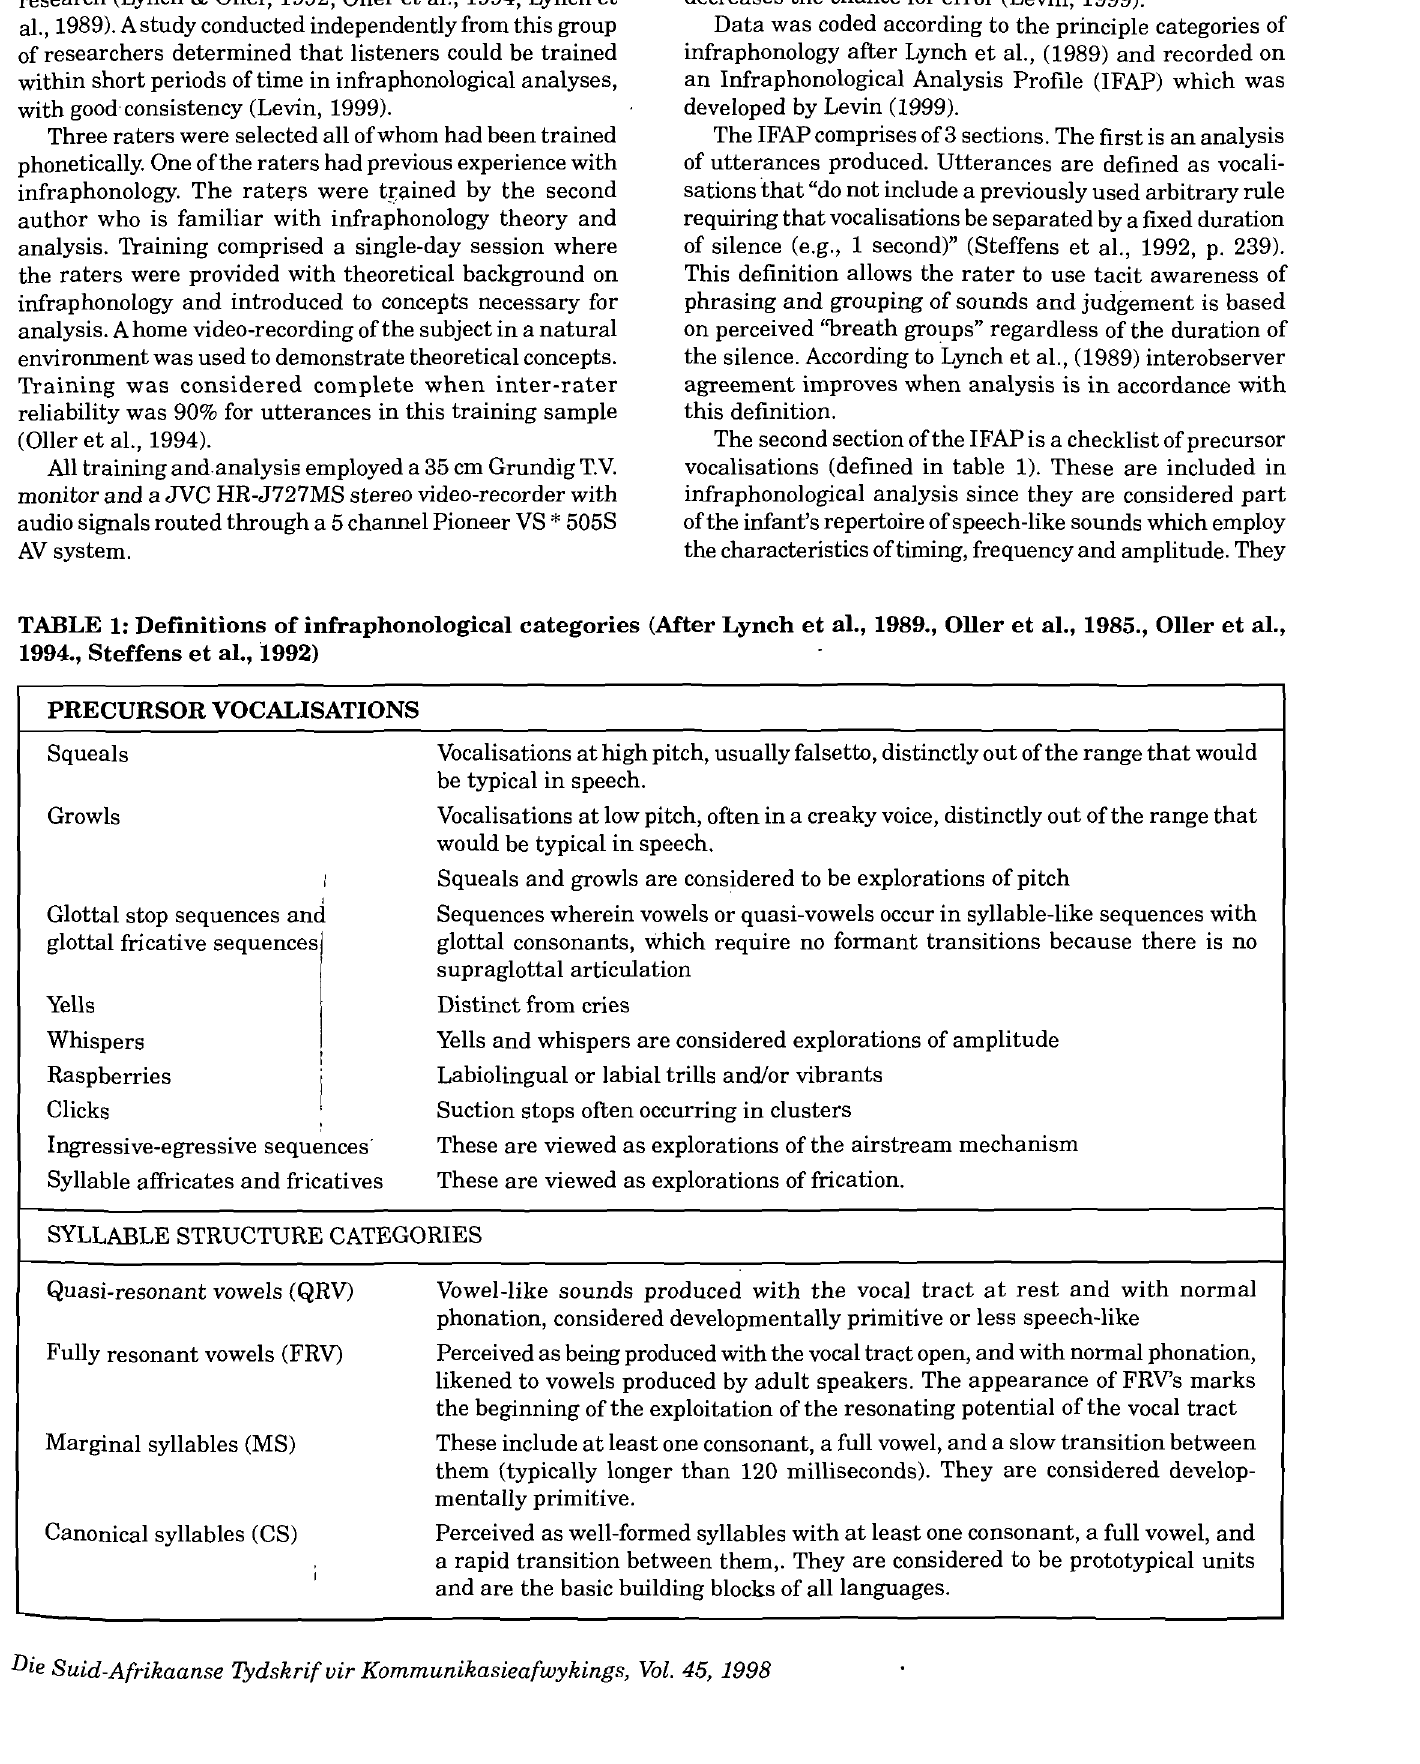
TABLE 1: Definitions of infraphonological categories (Mter Lynch et aI., 1989., Oller et aI., 1985., Oller et al., 1994., Steffens et al.,